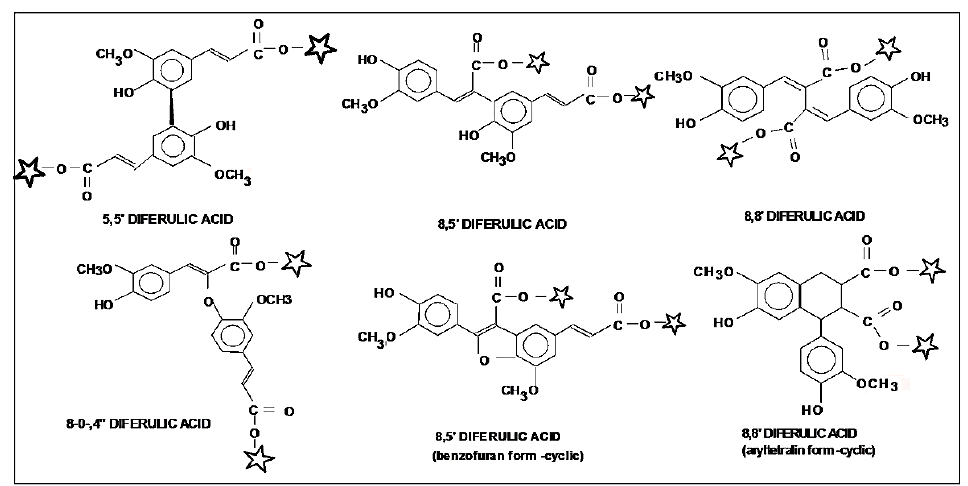
Figure 3. Schematic structure of ferulic acid (FA) dimers . 5,5 ′ -DFA; 8,5 ′ -DFA (or 8-5 benzofuran- DFA); 8,8 ′ -DFA; 8-O-4 ′ -DFA; 8,5 ′ -DFA (benzofuran cyclic form); 8,8 ′ -DFA (cyclic form). Abbreviations: DFA = diferulic acid. Stars highlight potential sites for esterification. Unpublished original data. Source P. Morris.